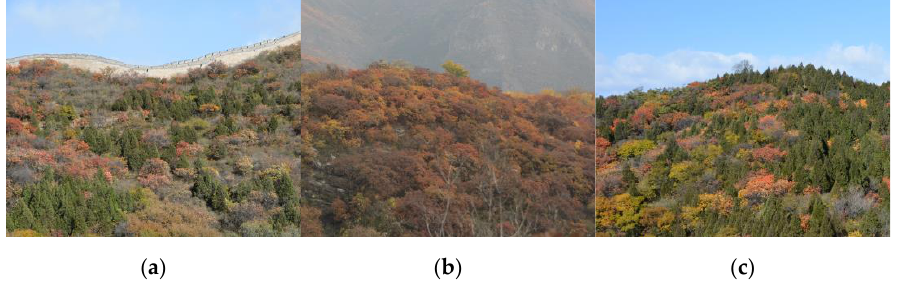
Figure 2. Randomly selected example photographs. ( a – c ) The photographs of Cotinus coggygria var. cinerea Engl. forest. cinerea Engl.